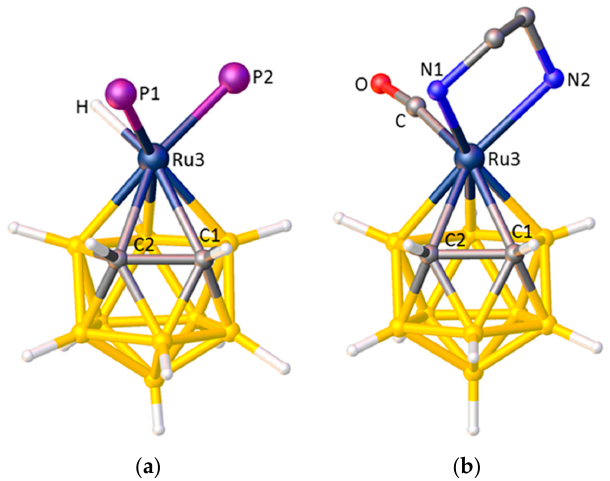
Figure 11. ( a ) The structure of the [3,3-(PPh 3 ) 2 -3-H- closo -3,1,2-RuC 2 B 9 H 11 ] − anion (phenyl rings omitted for clarity). Ru3 − P1(| θ | = 24.7°) 2.322(3), Ru3 − P2(| θ | = 116.7°) 2.294(3) Å, | θ | H = 136.4°, Ru3 −